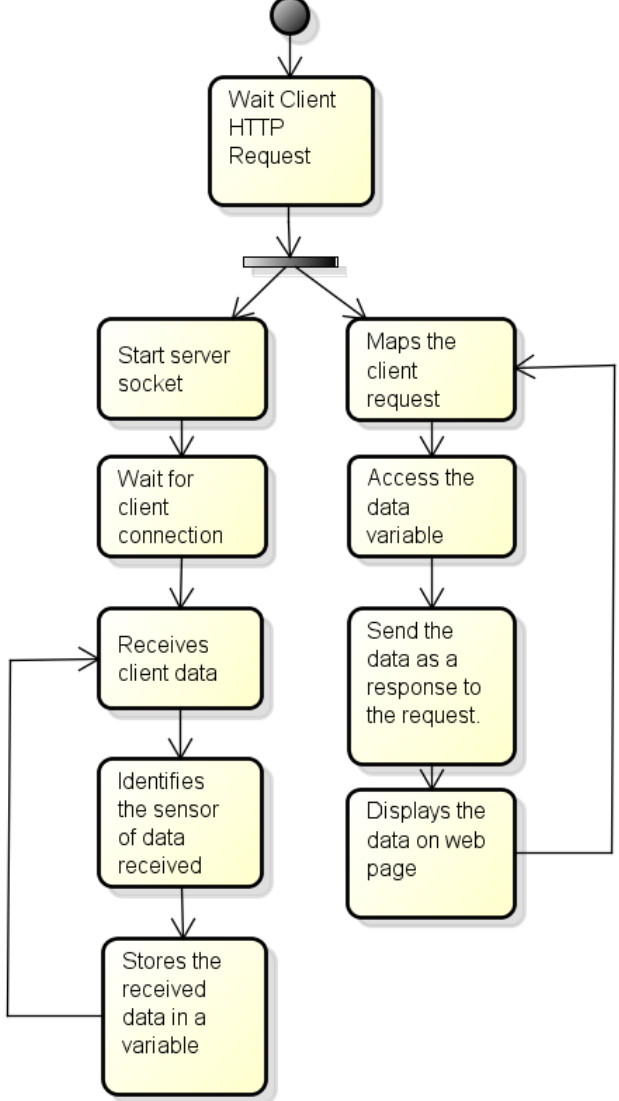
Figure 9. Algorithm of the server